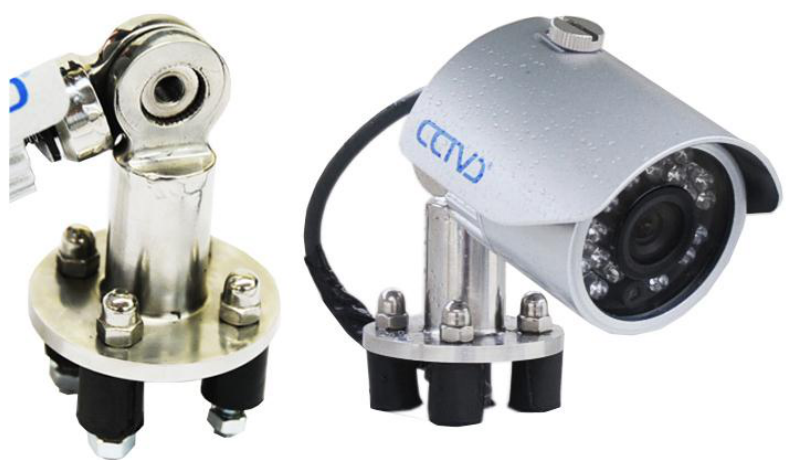
Figure 4. Camera ( right ) and mechanism of attachment to the body of the vehicle ( left